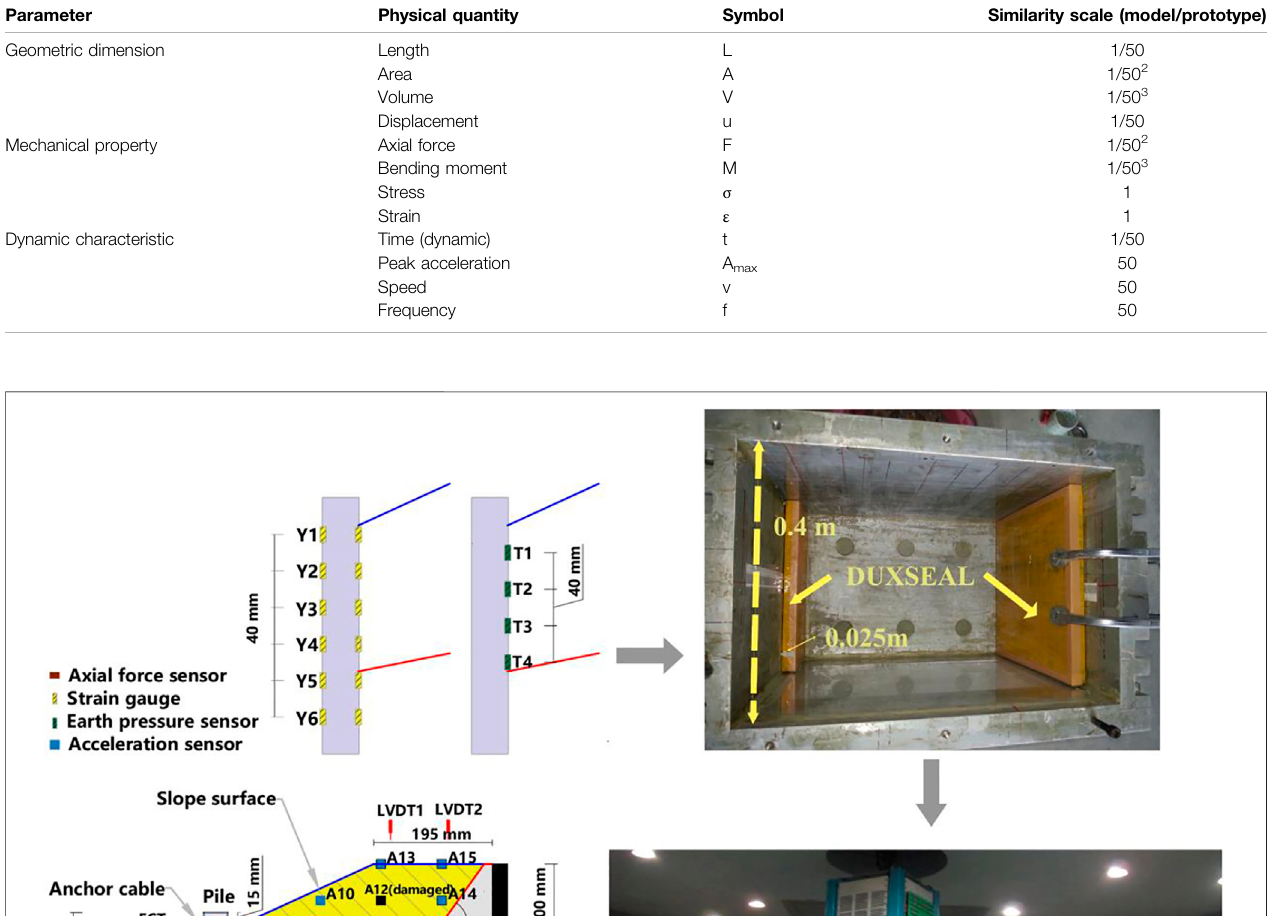
TABLE 1 | Similarity scale of the test model.